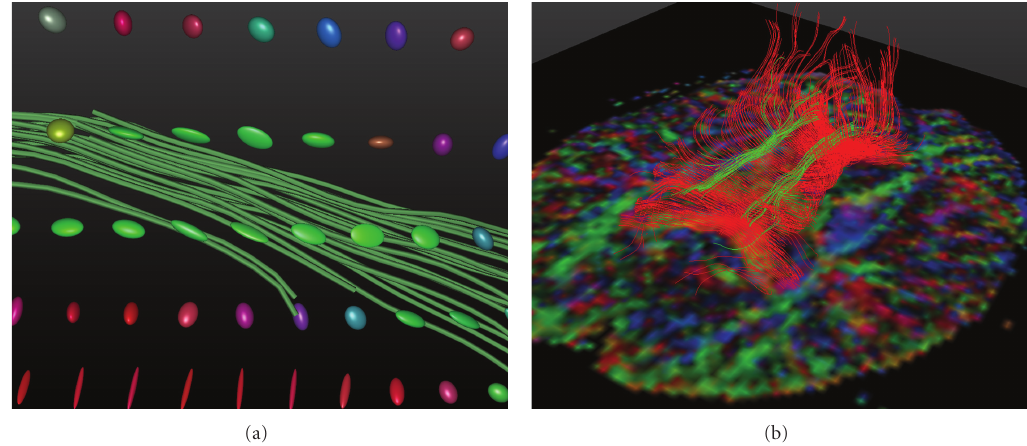
Figure 2: (a) Small group of fibers generated using a simple streamline method. The main eigenvectors of the di ff usion tensors determine the local orientation of the fibers. (b) Fibers showing part of the Cingulum and the corpus callosum. Both the glyphs in the left image and the plane in the right image use coloring based on the direction of the main eigenvector, similar to Figure 1. Both images were generated in the DTITool [11].